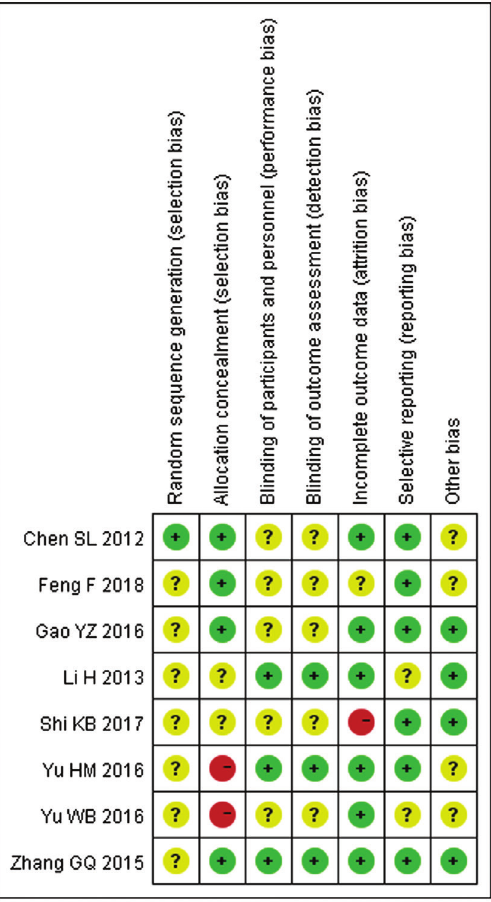
Figure 10. Risk of bias